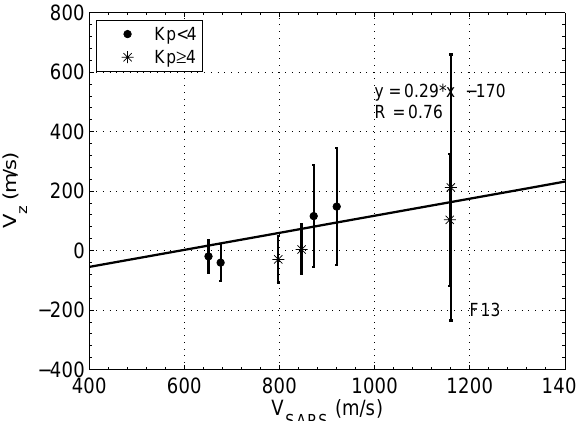
Fig. 8. Correlation of SAPS with the upflow velocity in the Northern Hemisphere. The correlation coefficient, ’R’, the regression line and the fitting function are also shown in the frame. The bars show the standard deviations of averages.